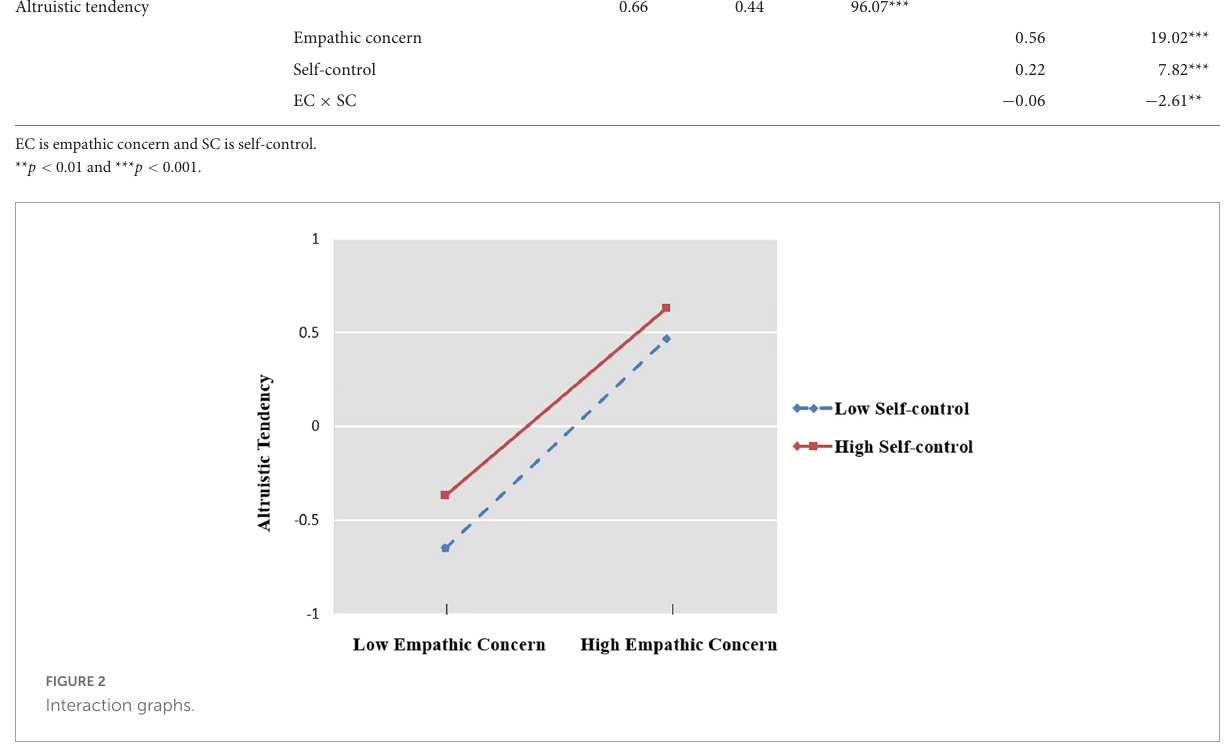
FIGURE2 Interaction graphs.